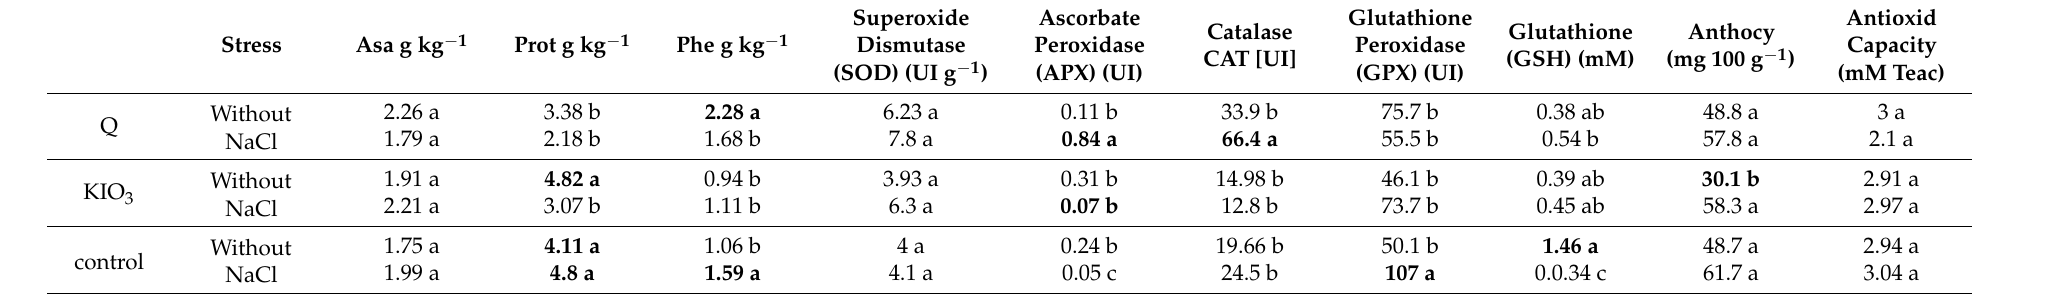
Table 4. Effect of iodine- based products on antioxidants content in strawberry fruits, with and without salt stress.